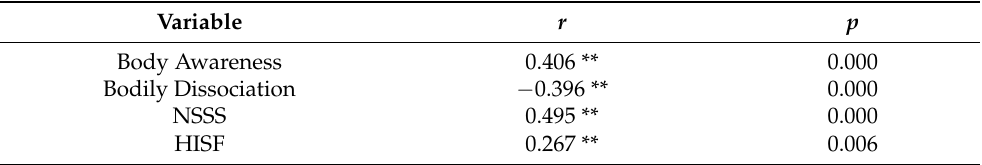
Table 3. Spearman correlations of the MAAS with subscales of: body awareness, bodily dissociation, sexual satisfaction (NSSS) and the Hurlbert Index of Sexual Fantasy